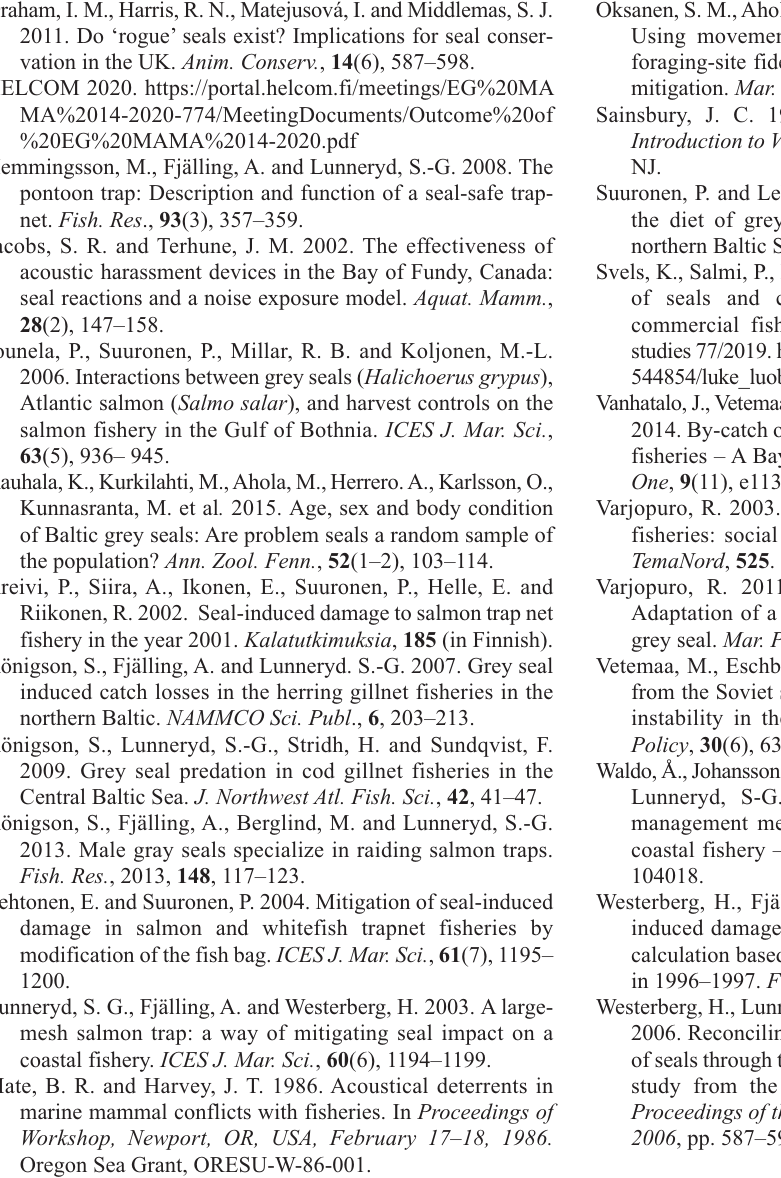
hüljeste tekitatud kahju rannapüügile umbes 0,9 miljonit eurot. Hülgekahjude leevendamise võimaluste uurimiseks testiti hülgepeleteid (Lofitech). Uuringus on esitatud kahjude kalkulatsioonid eri püügivahendite ja maakondade kaupa, samuti on võrreldud saake hülgepeletitega varustatud ning varustamata lõkspüünistes. Tulemused näitavad, et hülge - peletid pakuvad imetajate rünnakute vastu piisavat kaitset ja on seega efektiivsed ning nende soetamist tuleks riiklike vahenditega